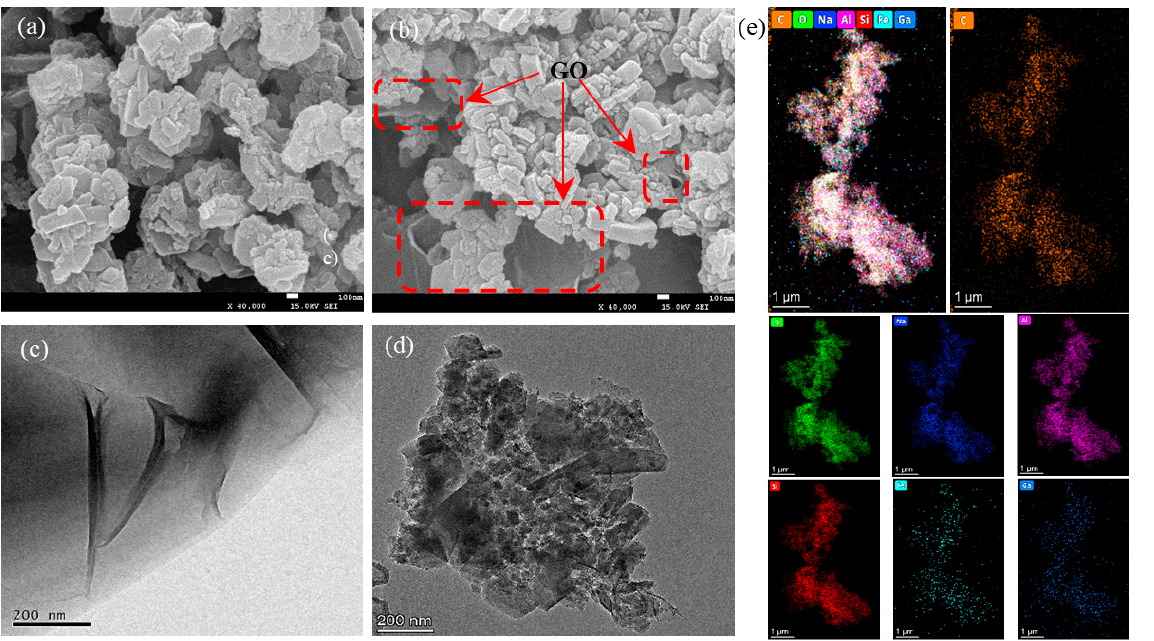
Figure 2. SEM images of HN-WSB-Z ( a ) and GZ ( b ), TEM images of GO ( c ) and GZ ( d ), and the element-mapping analysis of GZ ( e ).